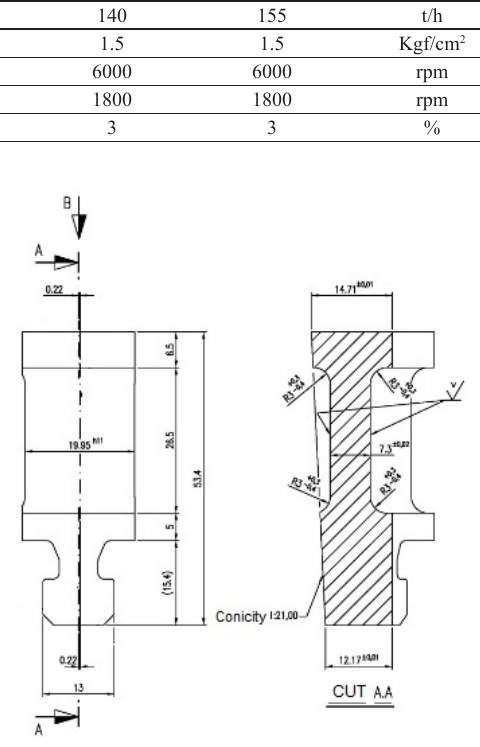
Figure 2. Geometry and dimensions(mm) of the turbine